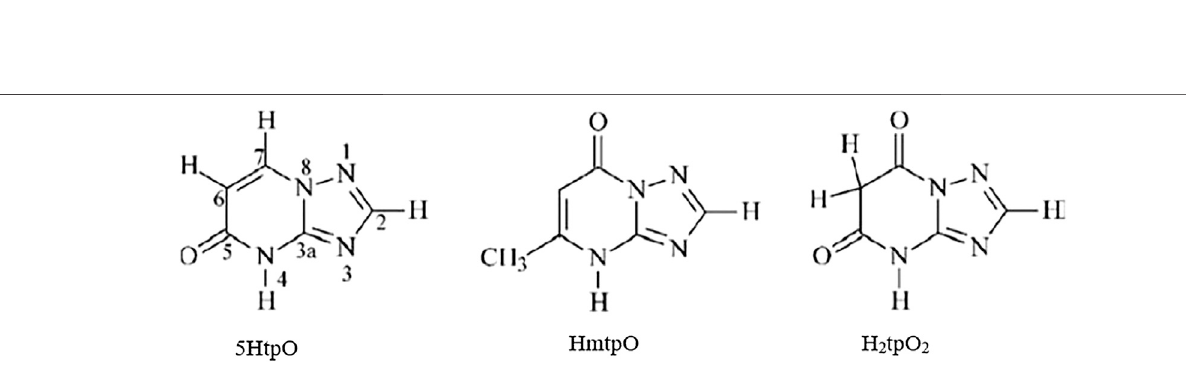
SCHEME 6 | Molecular structure of 25 – 28 (Girasolo et al., 2005; Attanzio et al.,